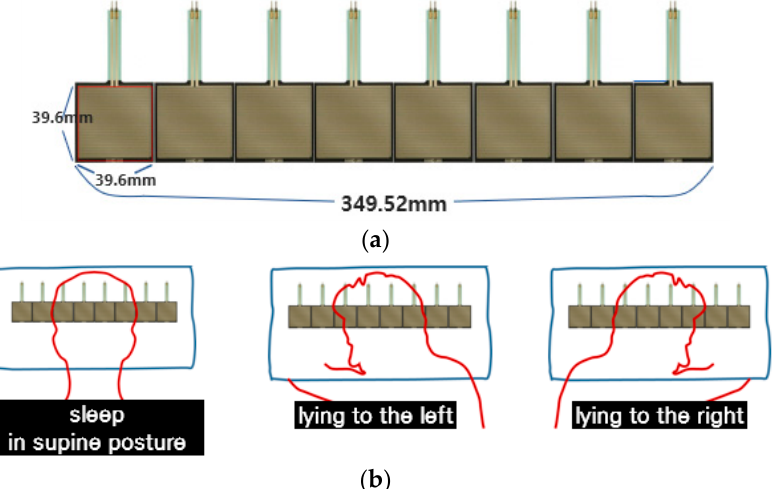
Figure 4. Smart pillow and the three sleeping postures it can distinguish. ( a ) Horizontal arrange- ment of eight FSR sensors; ( b ) sleeping postures that can be discriminated using the smart pillow.